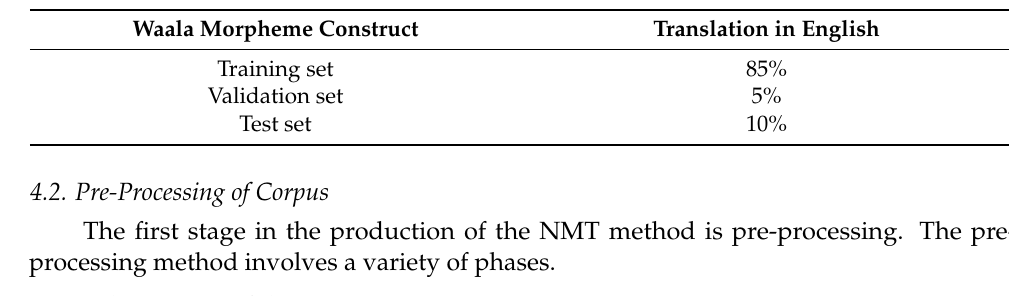
Table 6. Different sets of the parallel